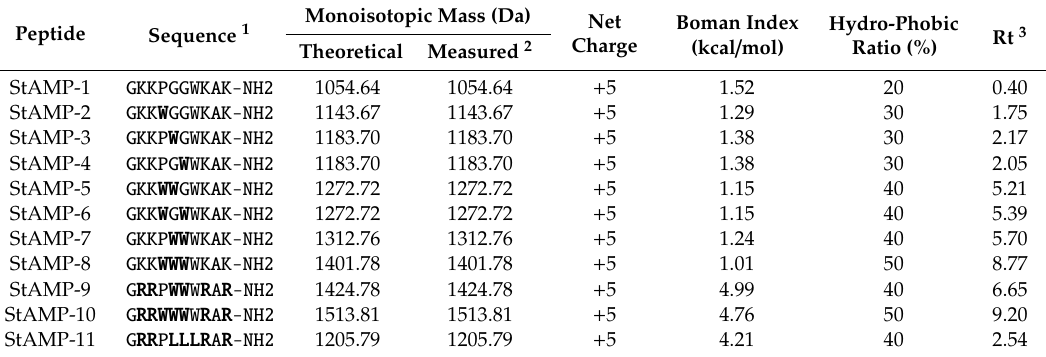
Table 2. Sequences and physicochemical properties of the synthesized StAMP-1-11 peptides. StAMP-1 corresponds to the C-terminal amidated first lead peptide sequence